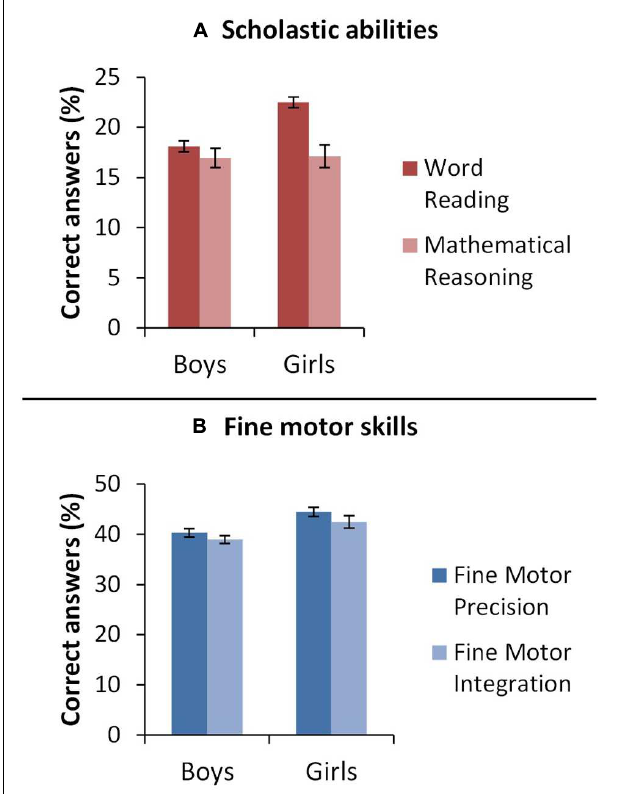
FIGURE 2 | Study 2. Bar graph representing mean performance (percentage of correct answer, y -axis) for boys and girls ( x -axis) on (A) scholastic skills and (B) fine motor skills. Error bars represent 1 standard